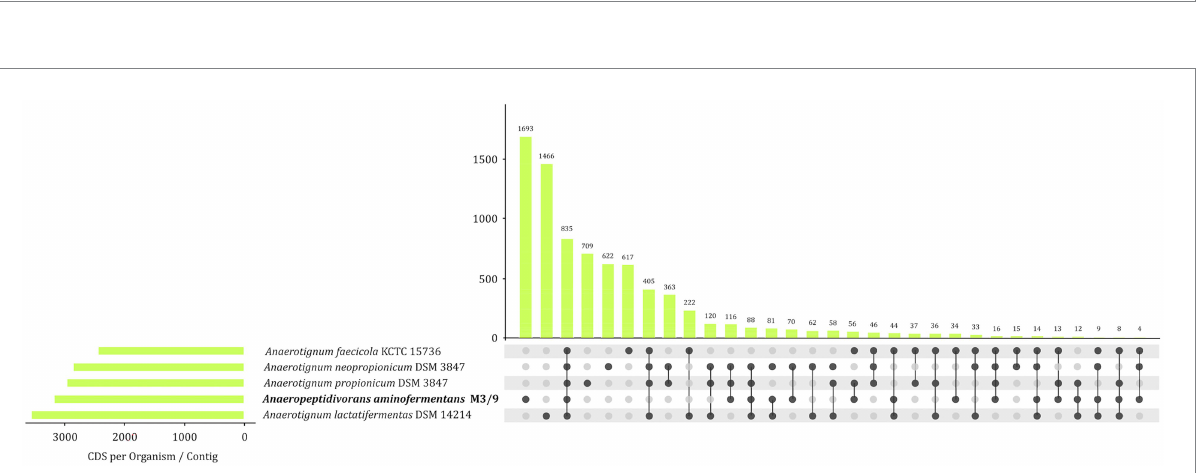
FIGURE 5 UpSet diagram illustrating the core genome and common genes among A. aminofermentans M3/9 T and closely related Anaerotignum species based on complete genome sequences of the type